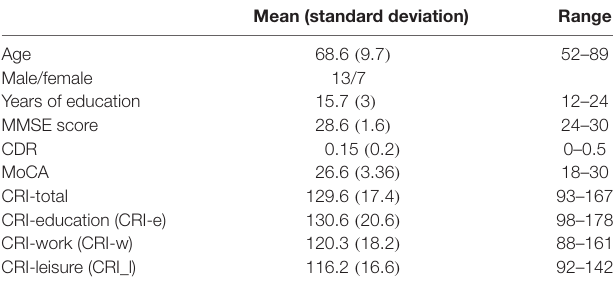
TABLE 1 | Demographic and cognitive characteristics of the studied group.